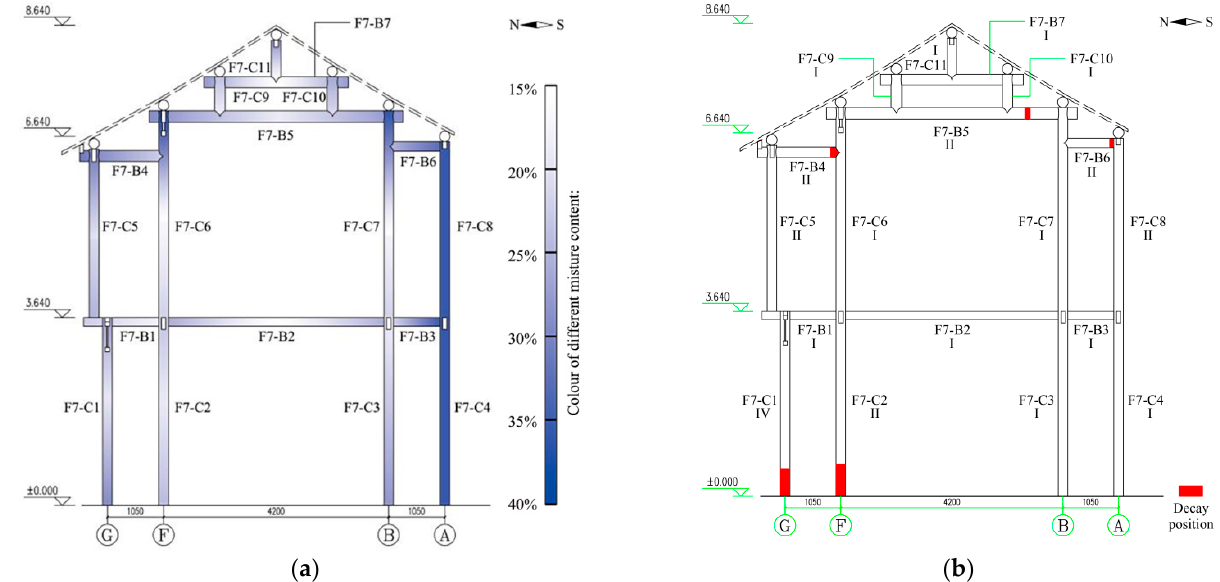
Figure 18. Moisture content and decay of F7 in Fujiu Zhou house; ( a ) schematic diagram of moisture content; ( b ) schematic diagram of decay position and decay grade.